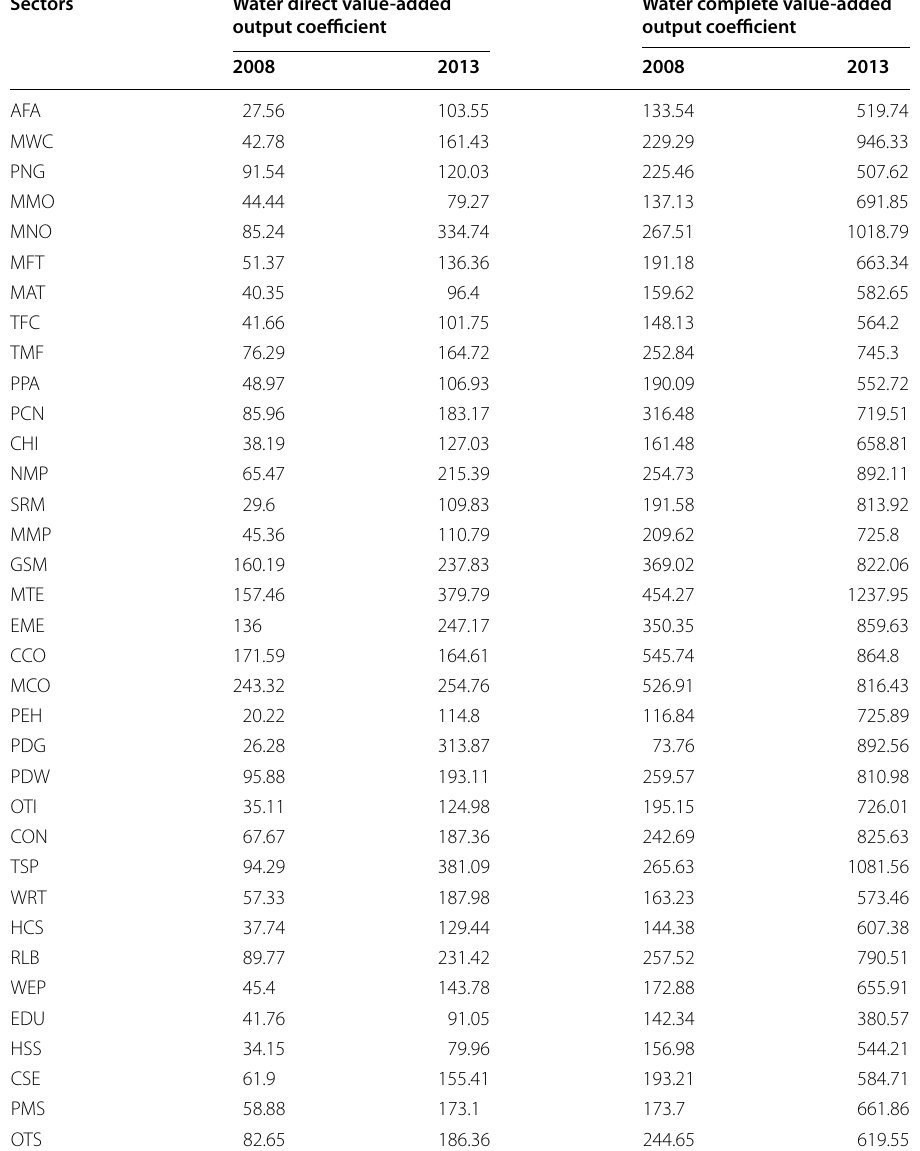
Table 3 Water direct and water complete value‑added output coefficients (RMB/m 3 )